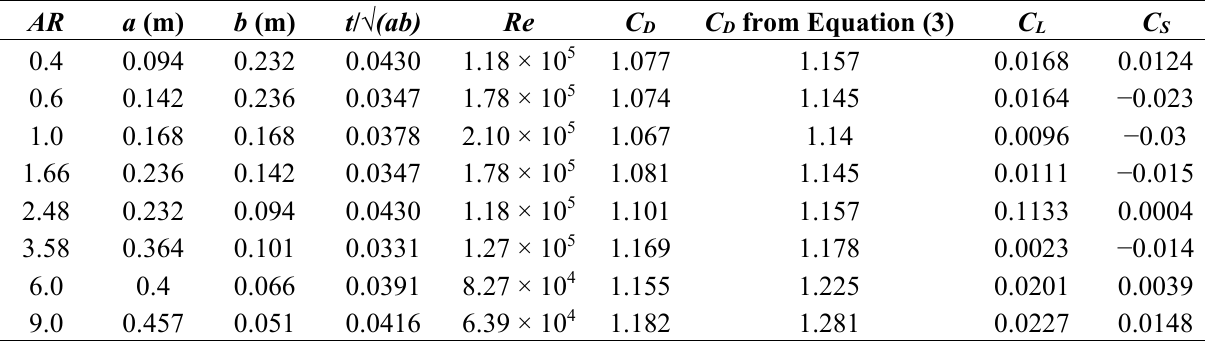
Table 2. Plate geometry and measured forces on a normal flat plate in the free